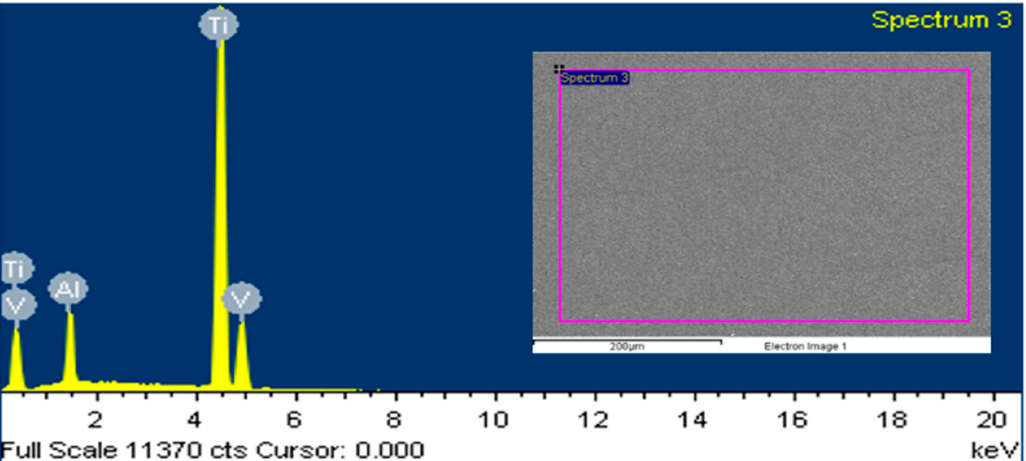
Figure 15. EDX Spectrum and SEM image of EBM produced Ti6Al4V ELI part.